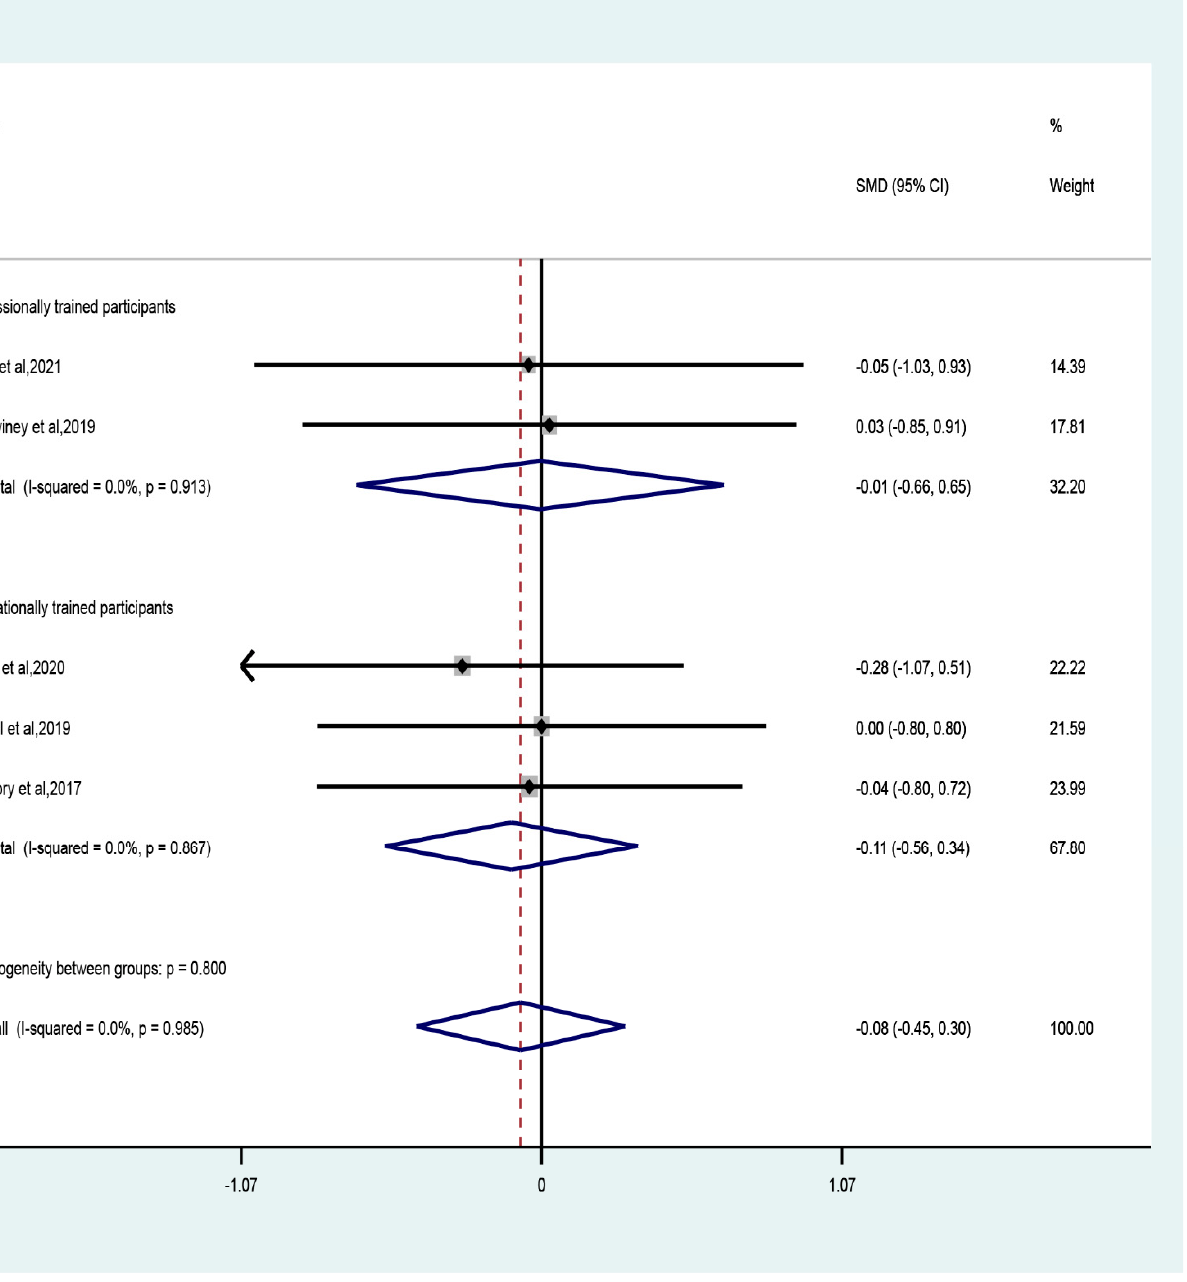
Figure 2. Forest plot of the effect of CT combined with LCHF on lean mass in recreationally trained or professionally trained participants [47–50,53].